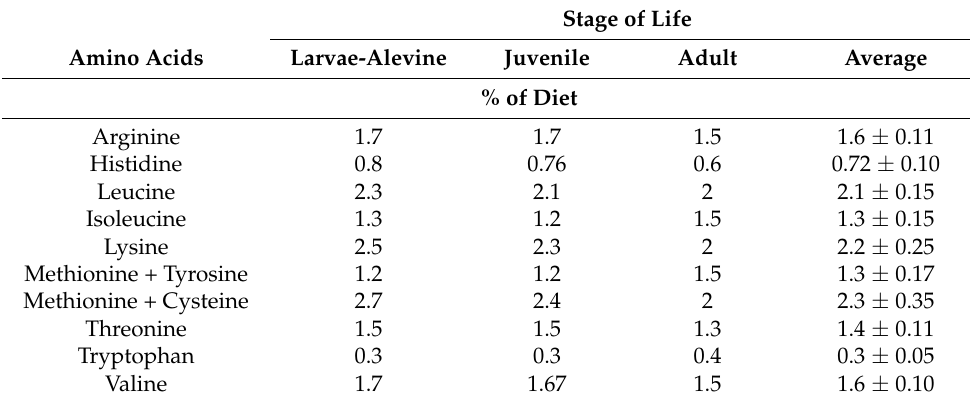
Table 3. National Research Council requirements of essential amino acids in fish diet in relation to stage of life. Adapted from Andersen et al.